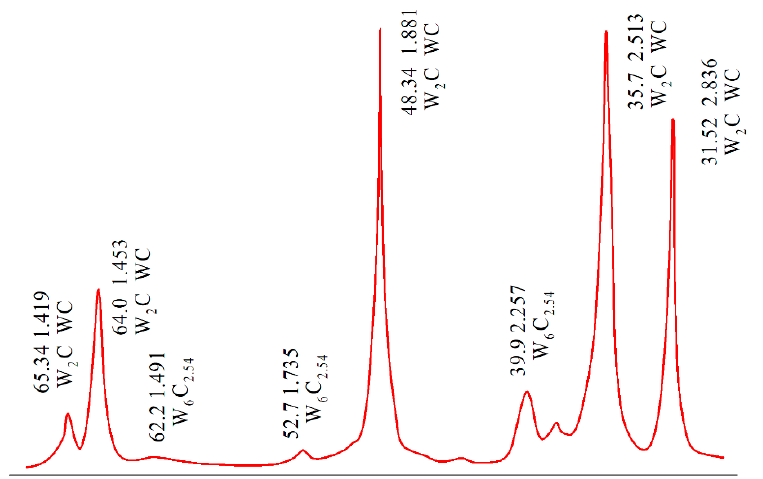
Figure 3. XRD of the WolCar obtained with electroconsolidation at T = 1700 ° С and Р = 45 М P а , for 2 min. 2